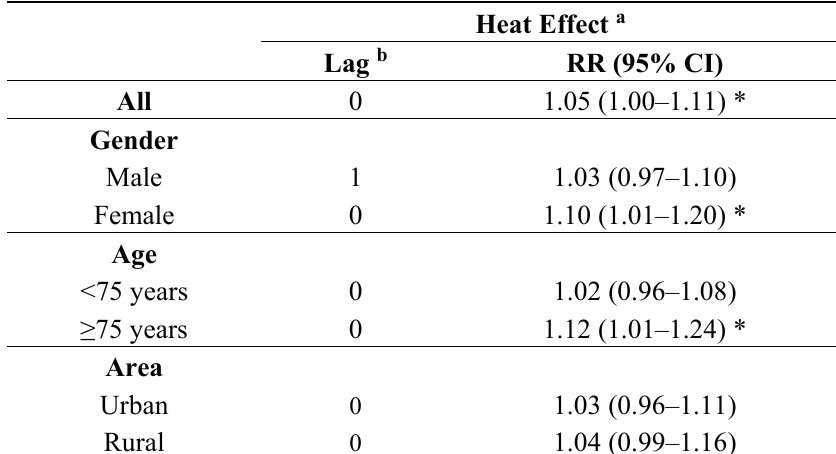
Table S1. The relative risk (RR) of heat effects on AMI hospital admissions in hot weather period by gender, age, and area.